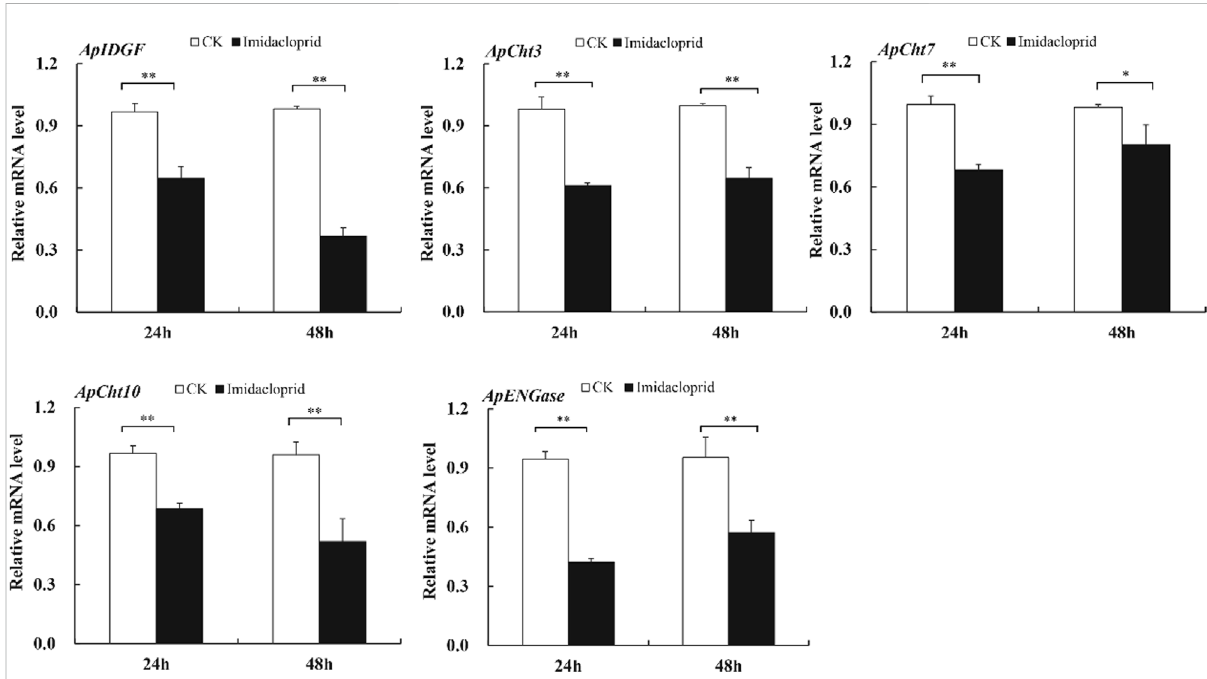
FIGURE 6 Expression of the Cht-related genes in response to insecticide stress. Different letters on the top of the columns indicate signi fi cance in the difference of expression levels by Tukey ‘ s HSD test at same treatment time (* p < 0.05 and ** p < 0.01 compared with the control group).